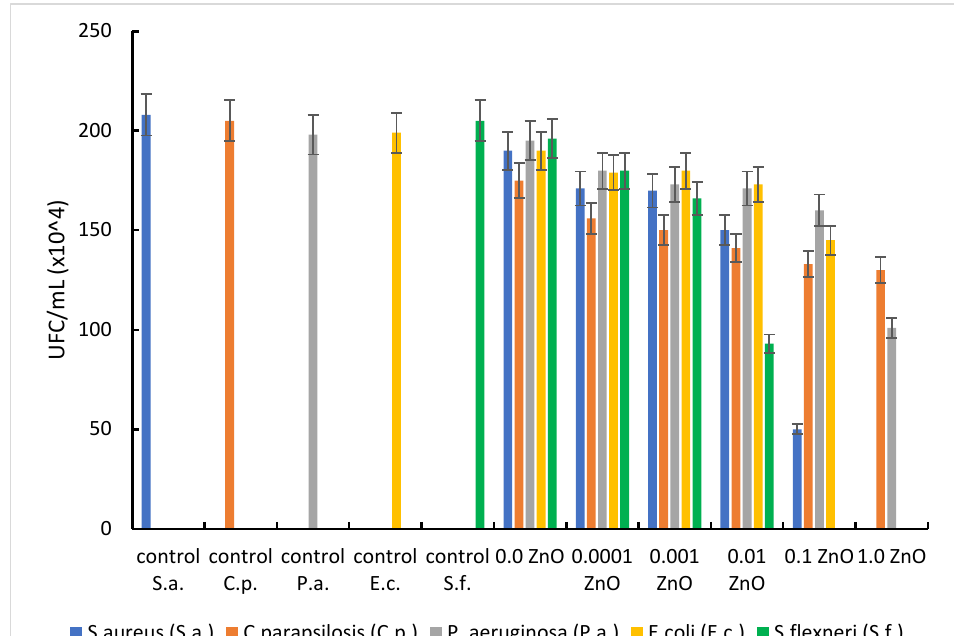
tested materials.